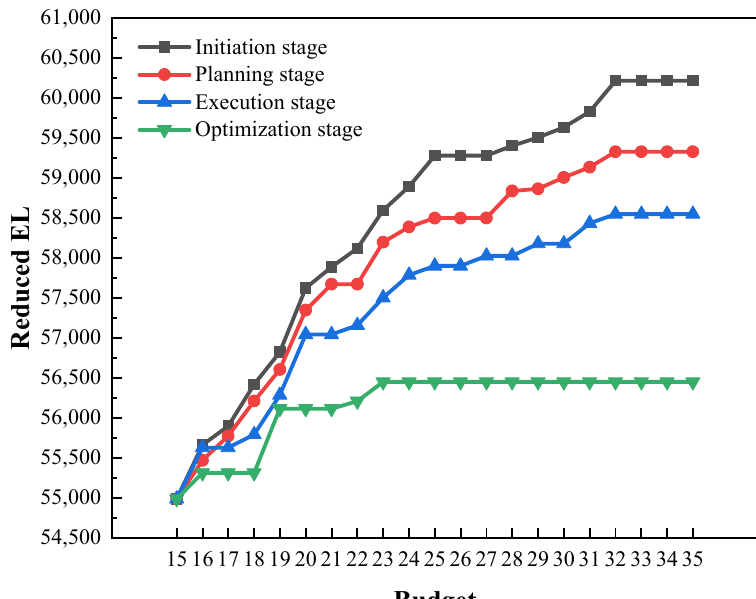
Figure 6. Reduced effects for different budgets and stages.